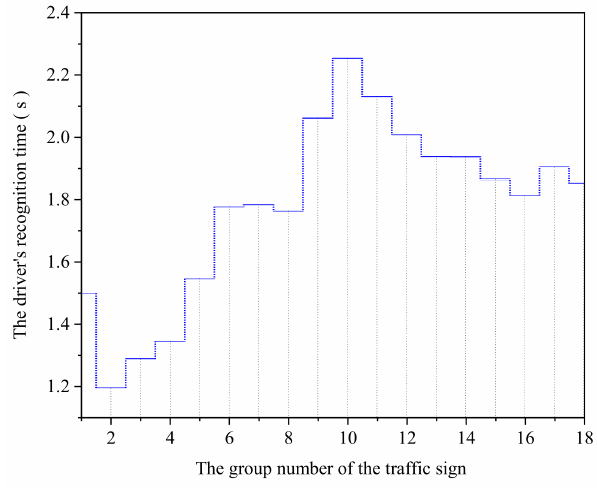
Figure 8. Modified driver’s recognition time.